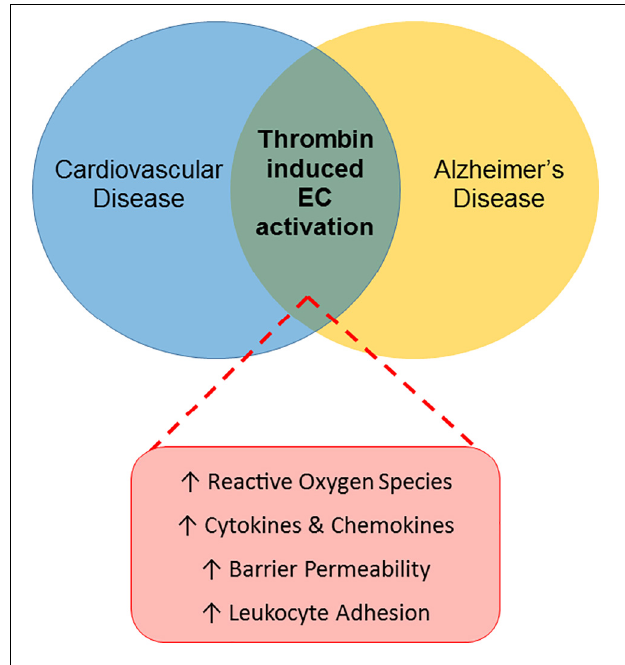
FIGURE 1 | Thrombin-induced endothelial cell activation: a link between CVRFs and AD. The Venn diagram illustrates a proposed role for thrombin-mediated endothelial cell (EC) injury as a common link between cardiovascular disease and AD. Thrombin’s proinflammatory effects on ECs in the periphery, characterized by increased reactive oxygen species, cytokines and chemokines, barrier permeability and leukocyte adhesion, contribute to the pathogenesis of cardiovascular disease. Similarly, thrombin may contribute to the development of AD by causing EC activation in the cerebral